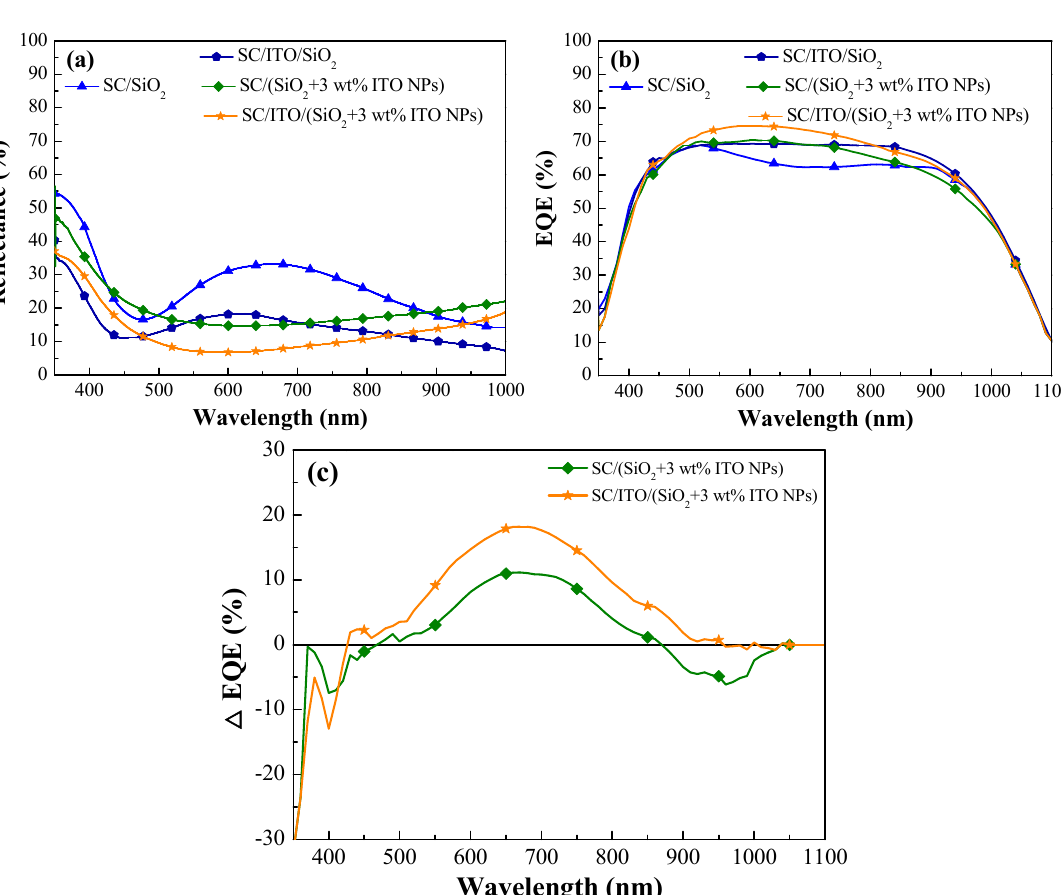
Figure 11. ( a ) Optical reflectance spectra and ( b ) external quantum efficiency (EQE) responses of a cell with an ARC of SiO 2 , a cell with an ARC comprising an ITO layer beneath a SiO 2 layer, a cell with an ARC of SiO 2 and 3 wt% ITO-NPs, and a cell with an ARC comprising an ITO layer beneath a layer of SiO 2 and 3 wt% ITO-NPs. ( c ) Δ EQE of a cell with an ARC of SiO 2 and 3 wt% ITO-NPs and a cell with an ARC comprising an ITO layer beneath a layer of SiO 2 and 3 wt% ITO-NPs, which was compared with the cell with a layer of SiO 2 (without ITO-NPs).